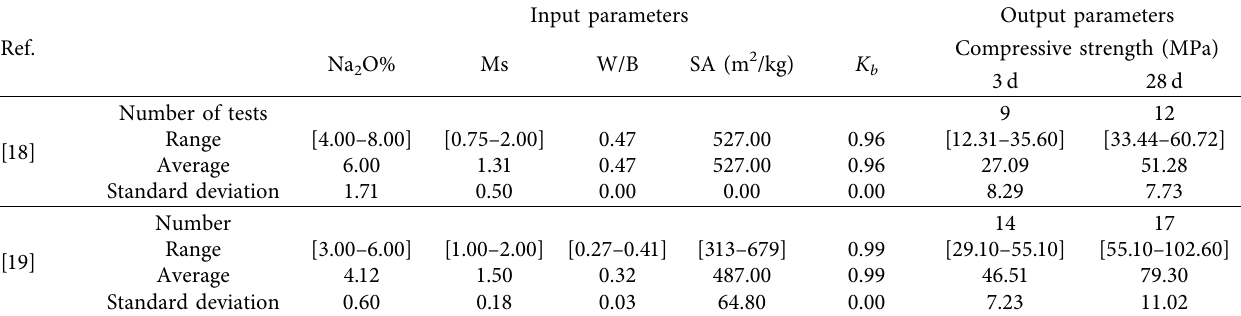
Table 2: Analysis of input/output